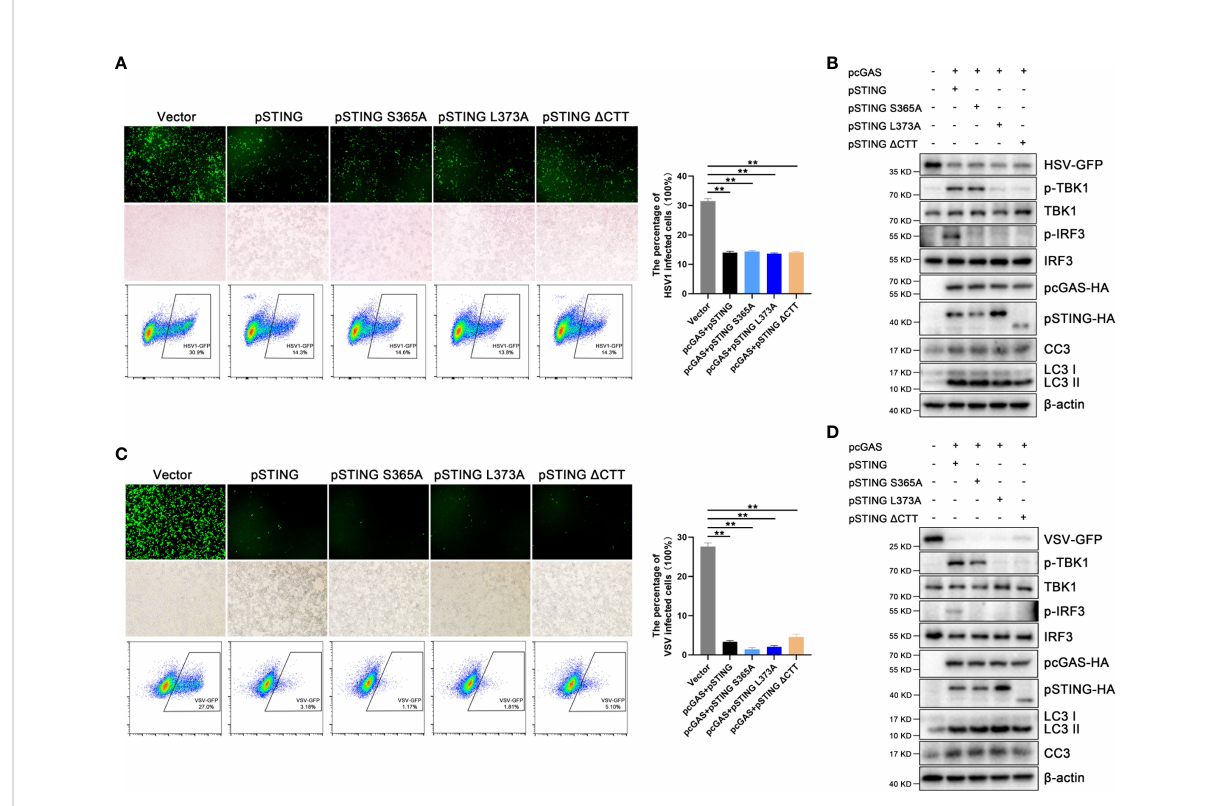
FIGURE 5 STING exerts antiviral effects independent of IFN. (A, B) 293T cells were co-transfected with pcDNA-pcGAS-2HA (0.5 m g) plus pcDNA-pSTING- 2HA or various mutants (each 0.5 m g) for 24 h, followed by HSV1 (MOI=0.01) infection for another 12 h. ** p < 0.01. (C, D) 293T cells were co- transfected with pcDNA-pcGAS-2HA (0.5 m g) and pcDNA-pSTING-2HA or various mutants (each 0.5 m g) for 24 h, followed by VSV (MOI=0.001) infection for another 8 h. Cells were analyzed for viral GFP signal by fl uorescence microscopy, viral GFP intensity by fl ow cytometry and protein expressions by Western blotting. ** p <